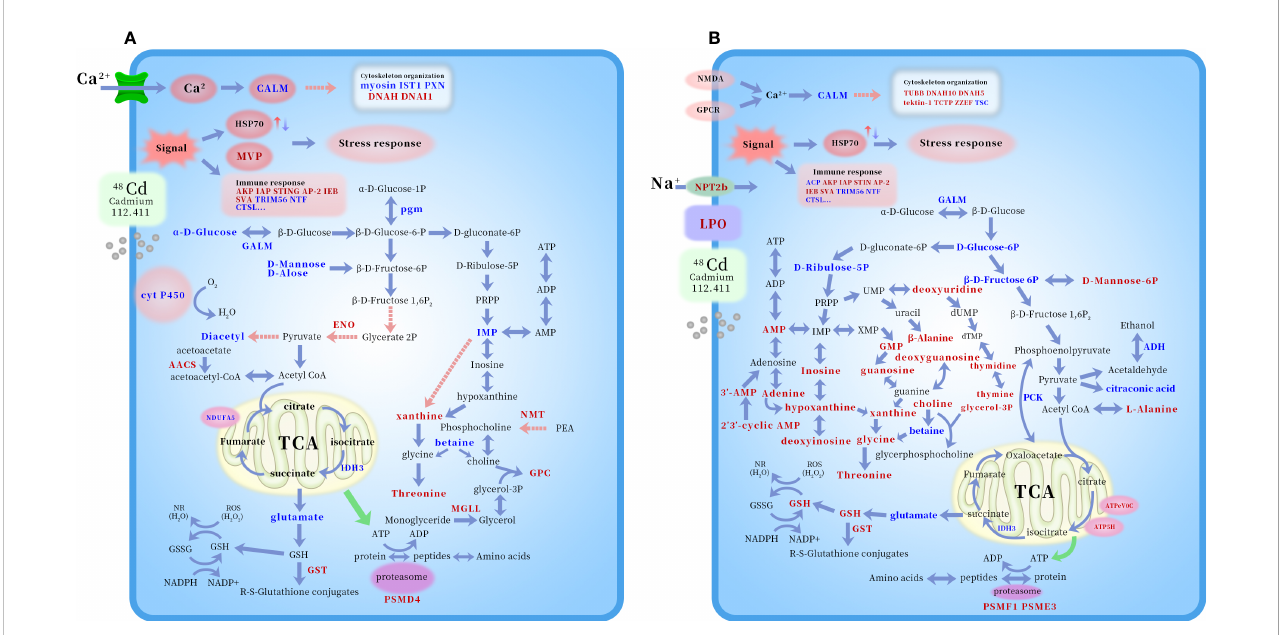
FIGURE 5 Potential mechanism schematic of Cd toxicology on deep-sea mussel G. platifrons according to KEGG (100 m g/L Cd, A and 1000 m g/L Cd, B). The altered proteins and metabolites were shown by marking the names in red (up-regulated) or blue (down-regulated) color. Abbreviations: ACP, acid phosphatase; AKP, alkaline phosphatase; IAP, baculoviral IAP repeat-containing protein 7-B isoform X3; STING, stimulator of interferon protein 2; AP-2, AP-2 complex subunit alpha-2-like; IEB, interleukin enhancer-binding factor 2 homolog; SVA, superkiller viralicidic activity 2-like 2; TRIM56, E3 ubiquitin-protein ligase TRIM56-like; NTF, nuclear transport factor 2-like; CTSL: shell fi brous prismatic cathepsin-like protein 1; Myosin, unconventional myosin-XVI-like isoform X10; IST1, IST1 homolog; PXN, leupaxin-like isoform X2; DNAH, dynein heavy chain 6, axonemal-like isoform X3; DNAI1, dynein intermediate chain 2, ciliary isoform X2; TUBB, tubulin beta chain-like; DNAH10, dynein heavy chain 10, axonemal-like isoform X2; DNAH5, dynein heavy chain 5, axonemal- like isoform X2; TCTP, translationally-controlled tumor protein homolog; ZZEF, zinc fi nger ZZ-type and EF-hand domain-containing protein 1-like isoform X2; TSC, tubulin-speci fi c chaperone A; 3 ’ -AMP, Adenosine 3 ’ -AMP monophosphate; 2 ’ ,3 ’ -cyclic AMP, Adenosine 2 ’ ,3 ’ -cyclic monophosphate; D- Ribulose-5P, Ribulose 5 ’ -phosphate; PRPP, phosphoribosyl diphosphate; ATP5H, mitochondrial ATP synthase subunit d precursor; ATPeV0C, V-type proton ATPase 16 kDa proteolipid subunit; IDH3, isocitrate dehydrogenase [NAD] subunit beta, mitochondrial-like; NDUFA5, NADH dehydrogenase [ubiquinone] 1 alpha subcomplex subunit 5; ADH, cinnamyl alcohol dehydrogenase 8-like isoform X2; GPC, Glycerophosphocholine; PEA, phosphoethanolamine; Cyt P450, cytochrome P450 2C31; GST, glutathione S-transferase; HSP70, heat-shock protein 70 family; CALM. Calmodulin; pgm, Phosphoglucomutase-1; GALM, aldose 1-epimerase isoform X1; ENO, enolase 4-like isoform X4; AACS, acetoacetyl-CoA synthetase-like; NMT, phosphoethanolamine N-methyltransferase 3 isoform X1; MGLL, monoglyceride lipase-like isoform X1; PCK, phosphoenolpyruvate carboxykinase, cytosolic [GTP] isoform X1; NMDA, glutamate receptor ionotropic; NPT2b, sodium-dependent phosphate transport protein 2B-like isoform X1; GPCR, 5- hydroxytryptamine receptor 7; PSMD4, 26S proteasome non-ATPase regulatory subunit 4-like; PSMF1, Proteasome inhibitor PI31 subunit; PSME3, proteasome activator complex subunit